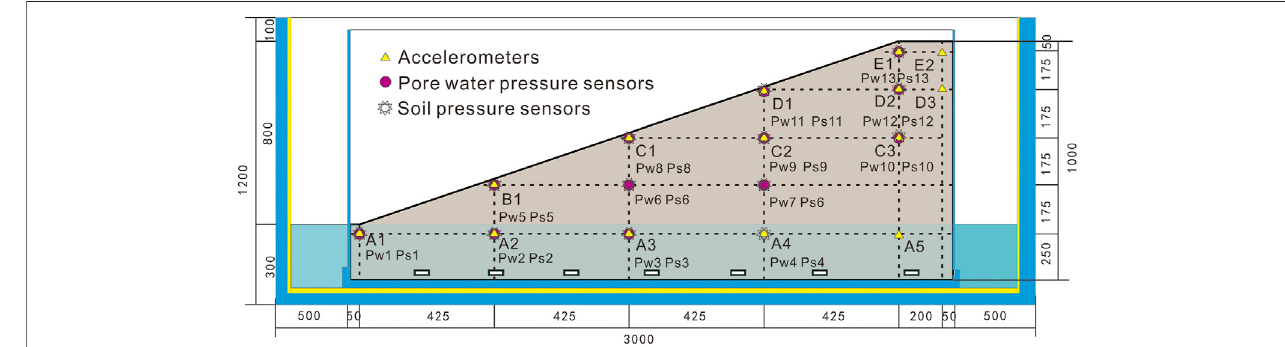
FIGURE 3 | Layout of the sensors (unit: mm).